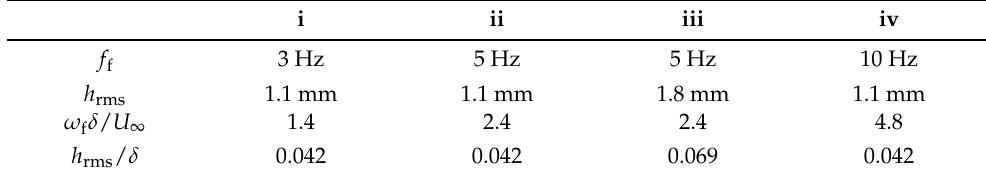
Table 2. Dynamic roughness actuation conditions (i–iv) explored in these experiments: dimensional, and non-dimensional quantities parameterized by motion rms height and frequency